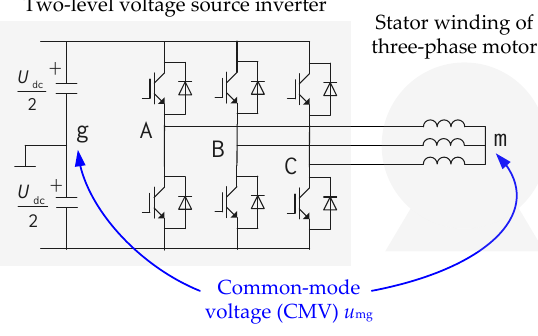
Figure 1. The system of a three-phase motor fed by a two-level voltage source inverter.